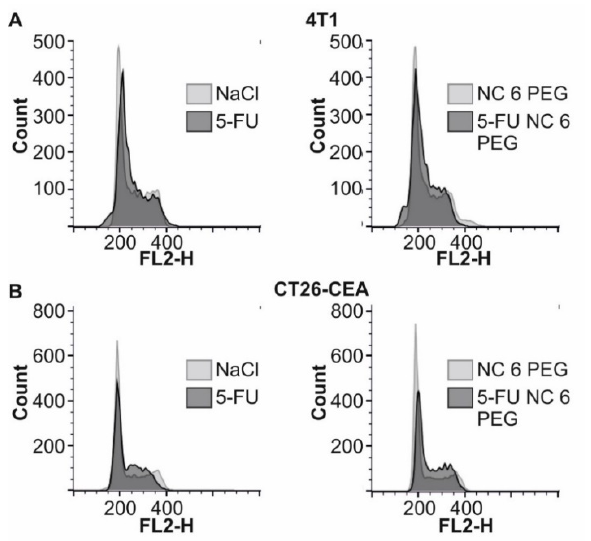
Figure 6. The effect of free and encapsulated 5-fluorouracil on the viability of murine cancer cells 4T1 ( A ) and CT26-CEA ( B ). The cells were incubated 48 h with empty nanocarriers, free or encap- sulated 5-fluorouracil. MTT analysis was performed to assess the cell viability. The error bars rep- resent the mean ± SD of at least three independent experiments using nanocarriers derived from three different syntheses.